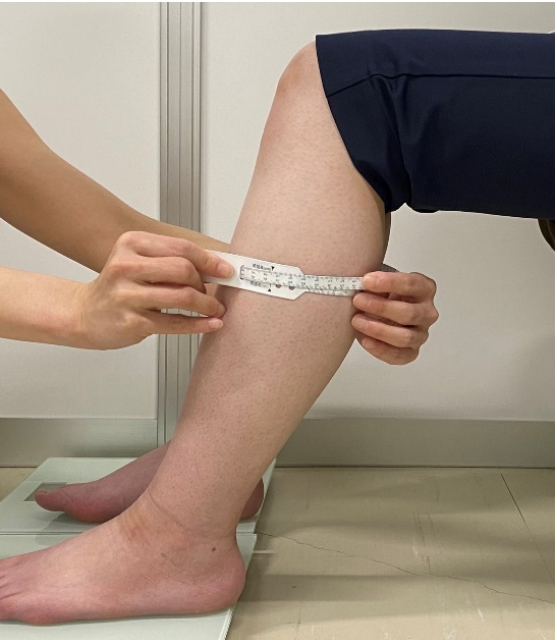
Figure 5. Measurement of calf circumference. The thickest part of the lower leg was measured three times, and the average value was calculated.